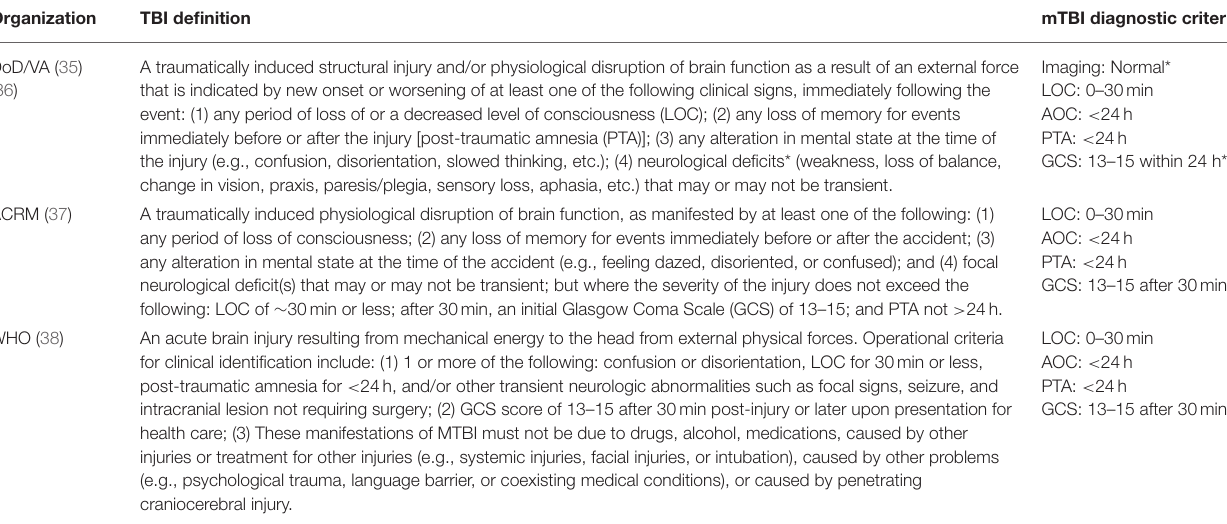
TABLE 2 | TBI definitions and diagnostic criteria.